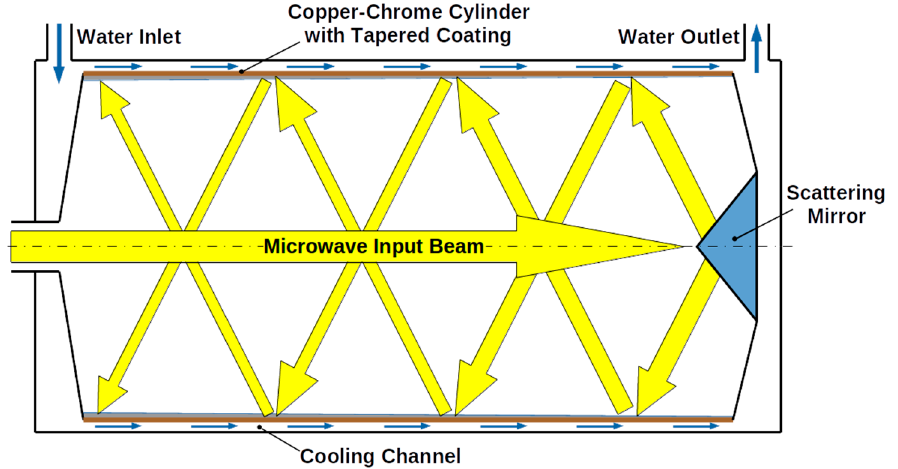
Figure 1. Concept of tube-shaped absorber featuring a microwave absorption layer with a varying coating thickness.